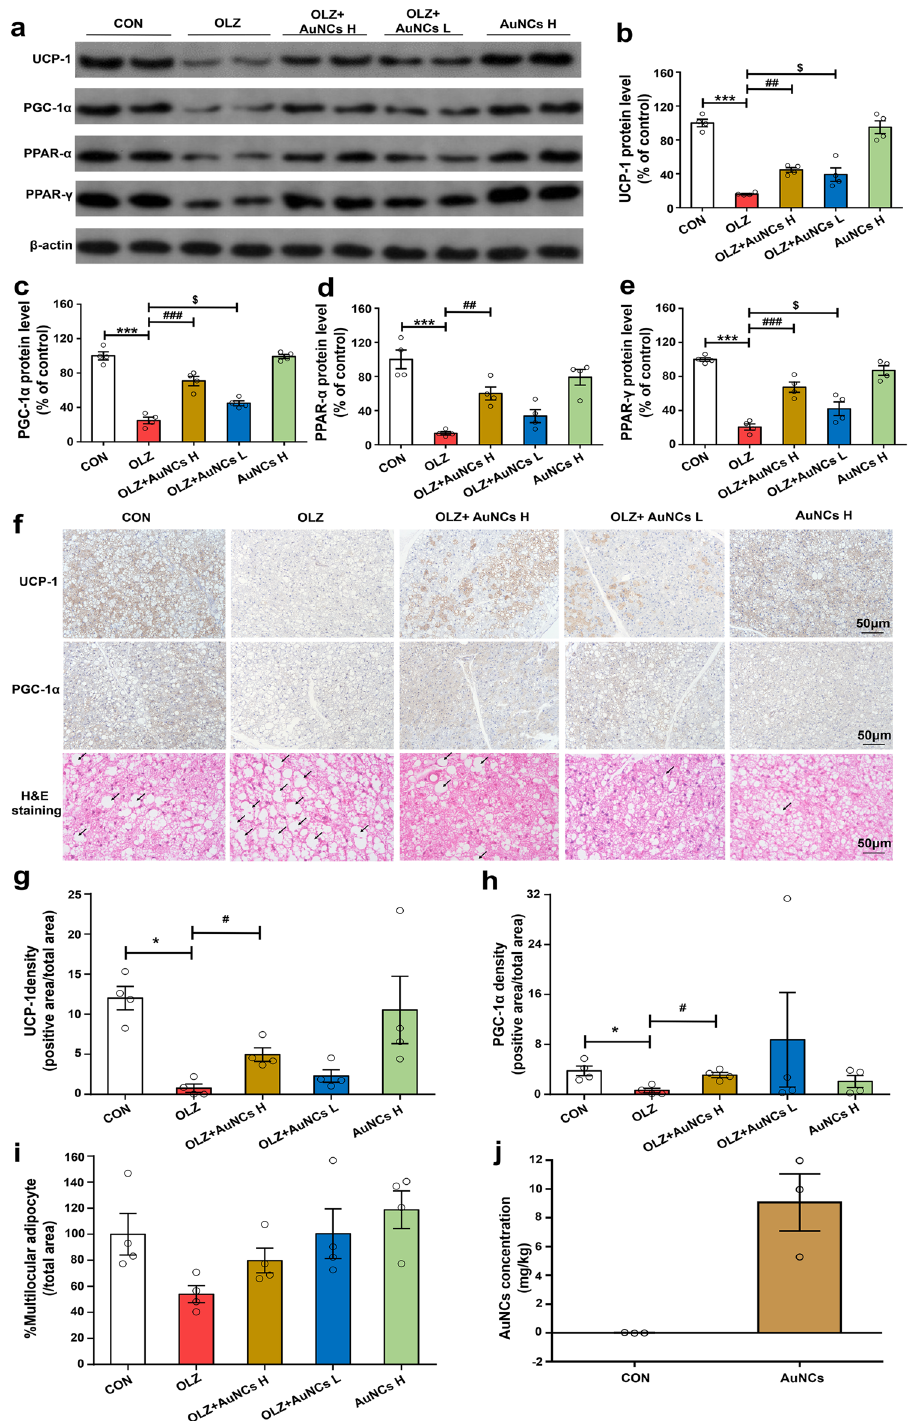
Figure 4. Effects of olanzapine and AuNCs co-treatment on the protein expression of BAT thermogenic markers. ( a ) Representative western blot figures of UCP-1, PGC-1α, PPAR-α, PPAR-γ protein expression in BAT. ( b – e ) Densitometry analysis of the protein expression of UCP-1 ( b ), PGC-1α ( c ), PPAR-α ( d ) and PPAR-γ ( e ). ( f ) Immunohistochemistry of UCP-1 and PGC-1α and H&E staining of BAT. ( g – i ) Quantification of relative positive area for UCP-1 ( g ), PGC-1α ( h ) and multilocular brown adipocytes ( i ). n = 4/group. ( j ) Concentrations of AuNCs in BAT of rats after administration of saline or 20 mg/kg AuNCs for 2 h. n = 3/group. All data were presented as mean ± SEM. * p < 0.05, *** p < 0.0001, OLZ vs . CON; # p < 0.05, ## p < 0.01, ### p < 0.0001, OLZ + AuNCs H vs . OLZ; $ p < 0.05, OLZ + AuNCs L vs . OLZ. Original figures were shown in Fig.